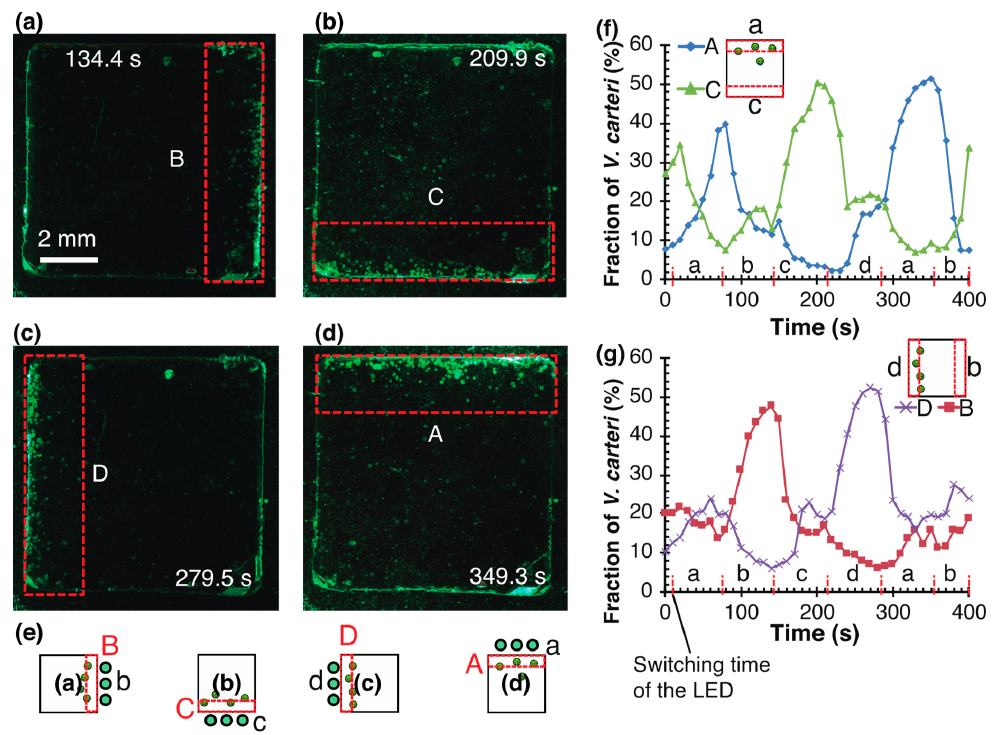
Figure 4. Motion control results of V. carteri in a closed micro chamber with the light irradiation platform. ( a – d ) Micrographs showing a state of motion control of V. carteri (green points). ( e ) Schematic of Volvox in areas A–D with LEDs a–d. ( f ), ( g ) time is plotted on the horizontal axis and the number of V. carteri is plotted on the vertical axis. These graphs separately plot A, C and B, D that face each other. Red dashed lines represent the switching time of the LED ( a , b , c , d ).